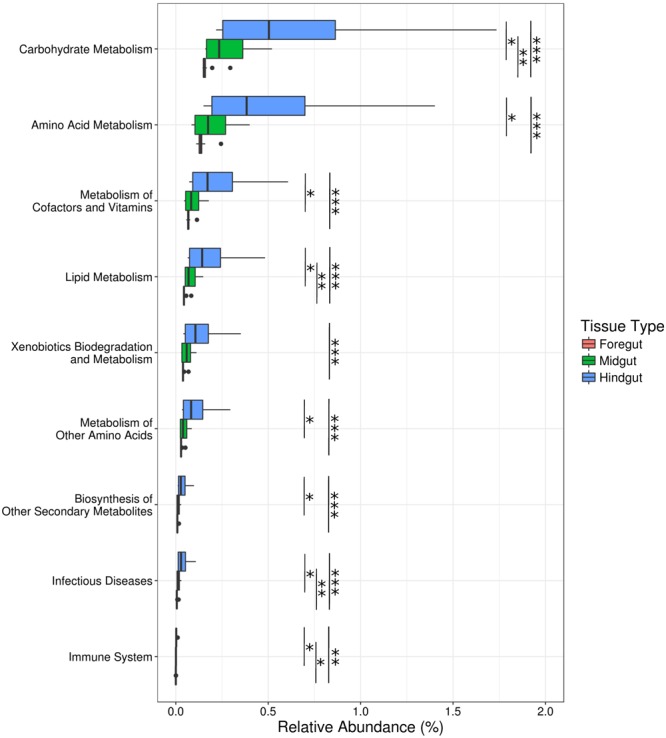
Relative abundance of KEGG pathways related to nutrition, immunity, xenobiotic degradation, and secondary metabolite production among tissue types. Sample sizes are foregut (n = 11), midgut (n = 11), and hindgut (n = 9). ∗p < 0.05, ∗∗p < 0.01, ∗∗∗p < 0.001.